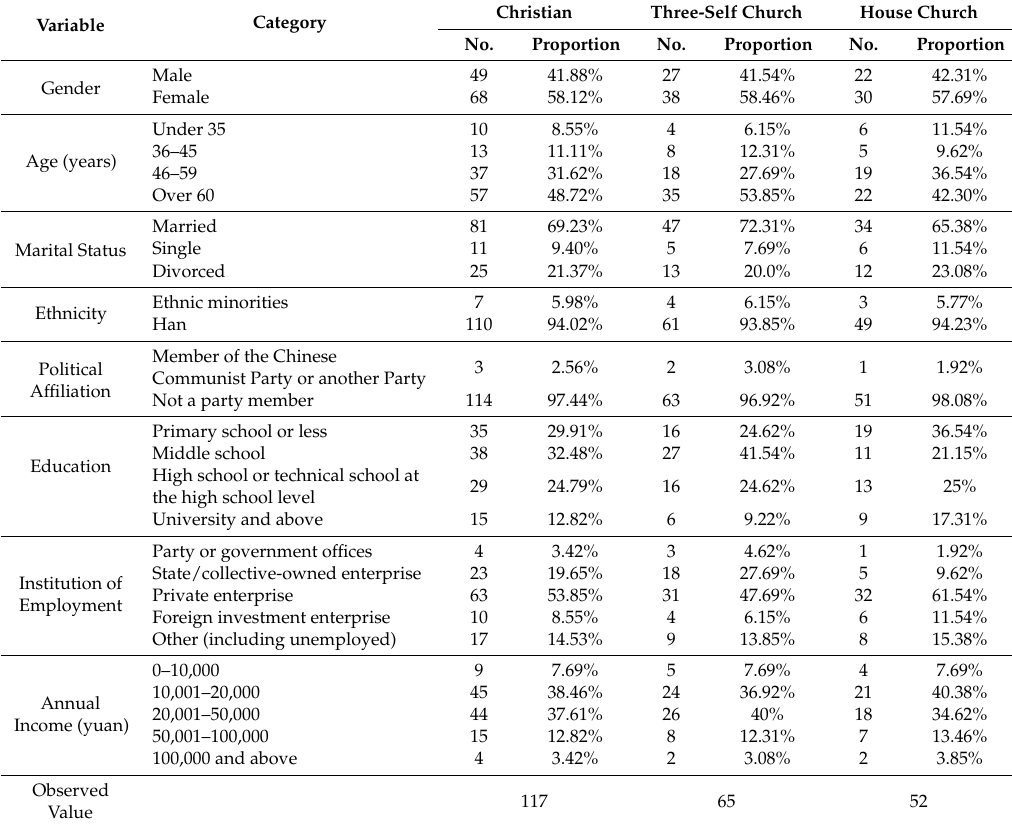
Table 1. Descriptive statistics of urban